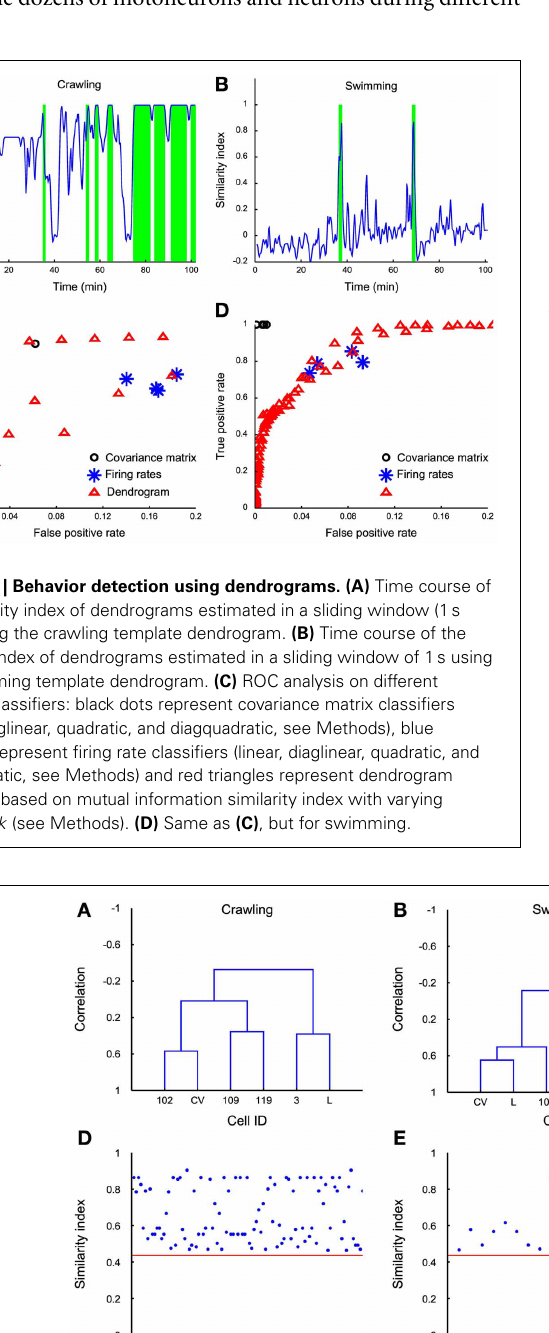
Similarity index between the estimated dendrogram in each behavioral episode (blue dots) and the average dendrogram. Red line indicates the average over similarity indexes between all average dendrogram couples. Its low value represents good distinction among all